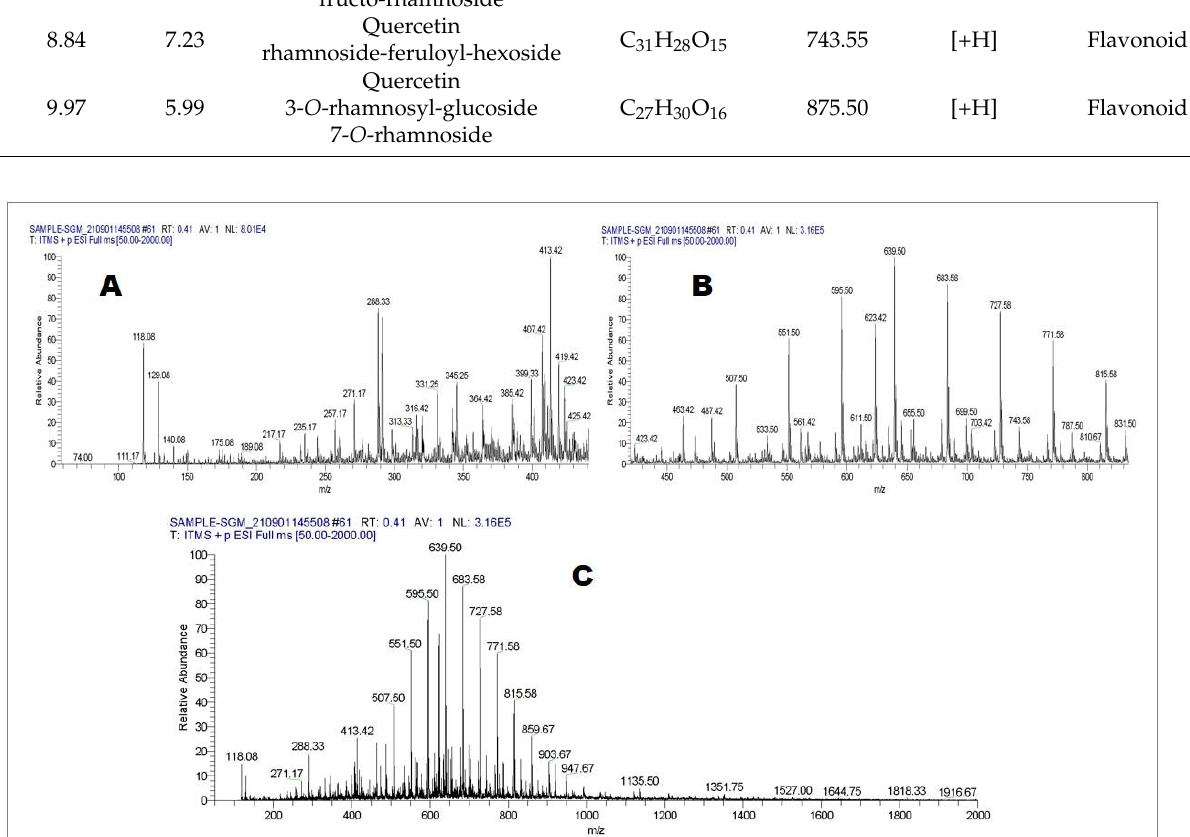
Figure 3. LC-ESI-MS-MS full scan of Strobilanthes glutinosus (positive mode) 50 – 400 ( A ), 50 – 800 ( B ), and 50 – 2000 ( C ).